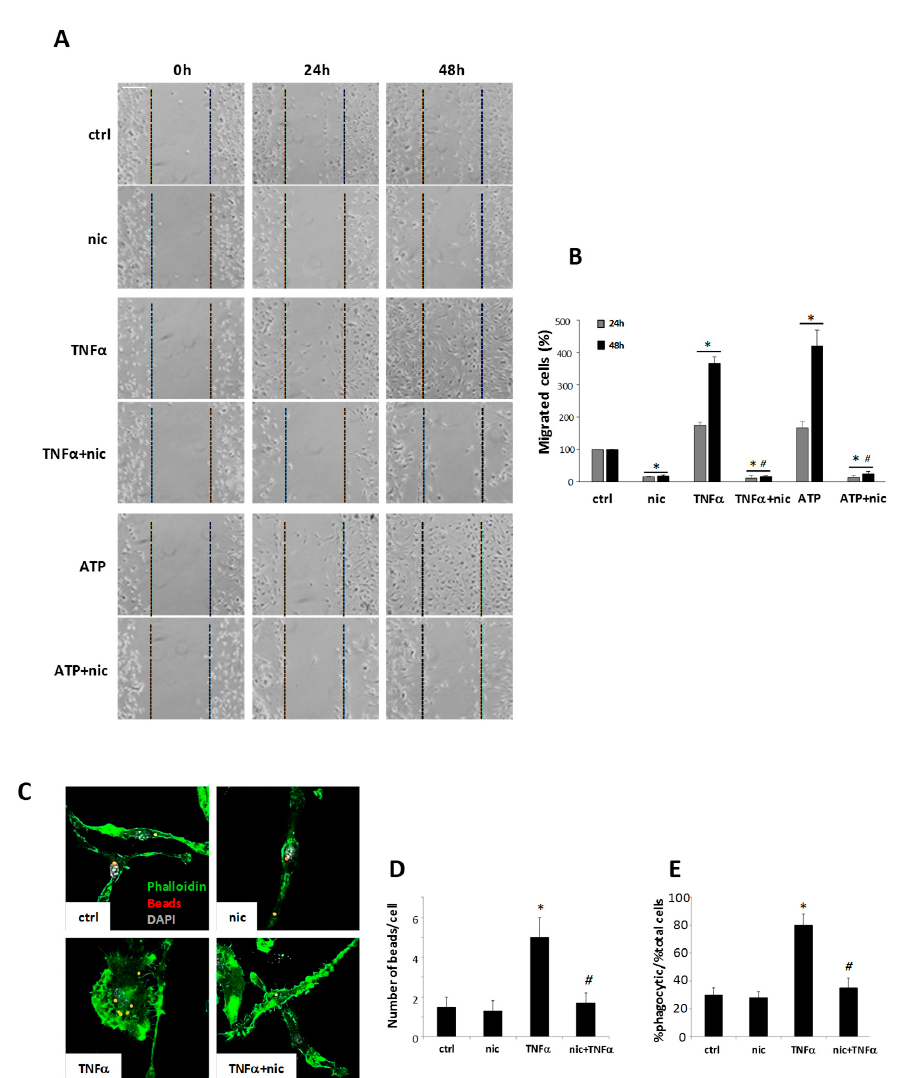
Figure 3. Niclosamide inhibits the migration and phagocytosis of TNF α -stimulated microglia . ( A ) Bright fields images of migration assay at 0, 24, or 48 h from the removal of the mini-chambers insert. Primary microglia inside the mini-chambers were pre-treated with DMSO (ctrl) or 100 nM niclosamide (nic) and after 24 h left free to migrate. After the removal of the mini-chambers inserts, microglia were stimulated with 50 ng / mL TNF α or 100 µ M ATP. Scale bar: 150 µ m. ( B ) Quantification of migrated cells (%) into the gap after 24 or 48 h from the removal of inserts. ( C ) Fluorescence images of phalloidin (green) and latex beads (red) on cells treated with DMSO (ctrl) or 100 nM niclosamide (nic) or 50 ng / mL TNF α for 48 h. DAPI was used for nuclei staining. Scale bar: 20 µ m. The number of beads / cell ( D ) and the % of phagocytic cells / % of total cells ( E ) were calculated. Data represent mean ± S.E.M. (n = 3 independent experiments). Statistical significance was calculated by ANOVA followed by Post